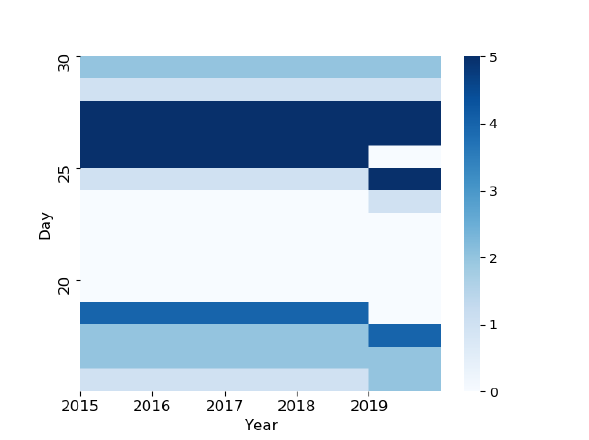
Figure 27: Clustering output for humidity for last 15 days in Q 3 over 2015 to